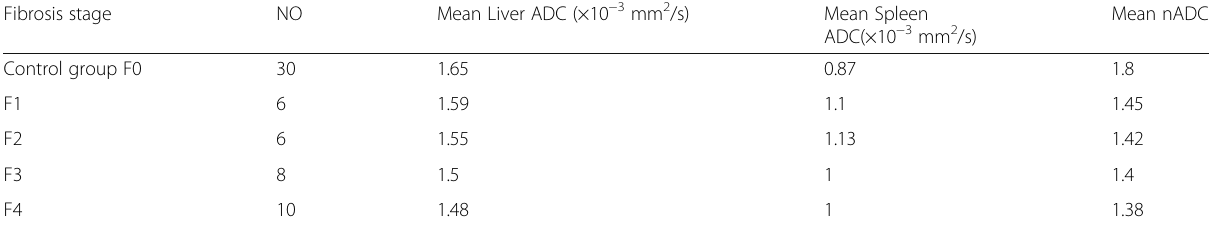
Table 3 Negative correlation was noted between liver ADC value as well as nADC with increasing fibrosis stage Fibrosis stage